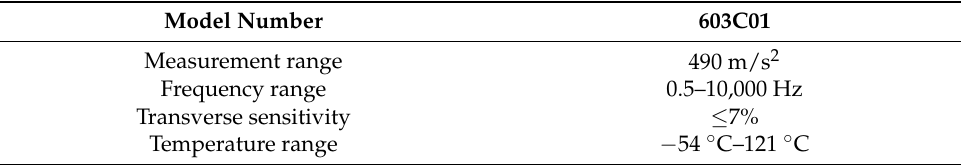
( b ) ( c ) Figure 4. Data collected from the simulator. ( a ) Normal data. ( b ) Rotor fault data. ( c ) Bearing fault data.